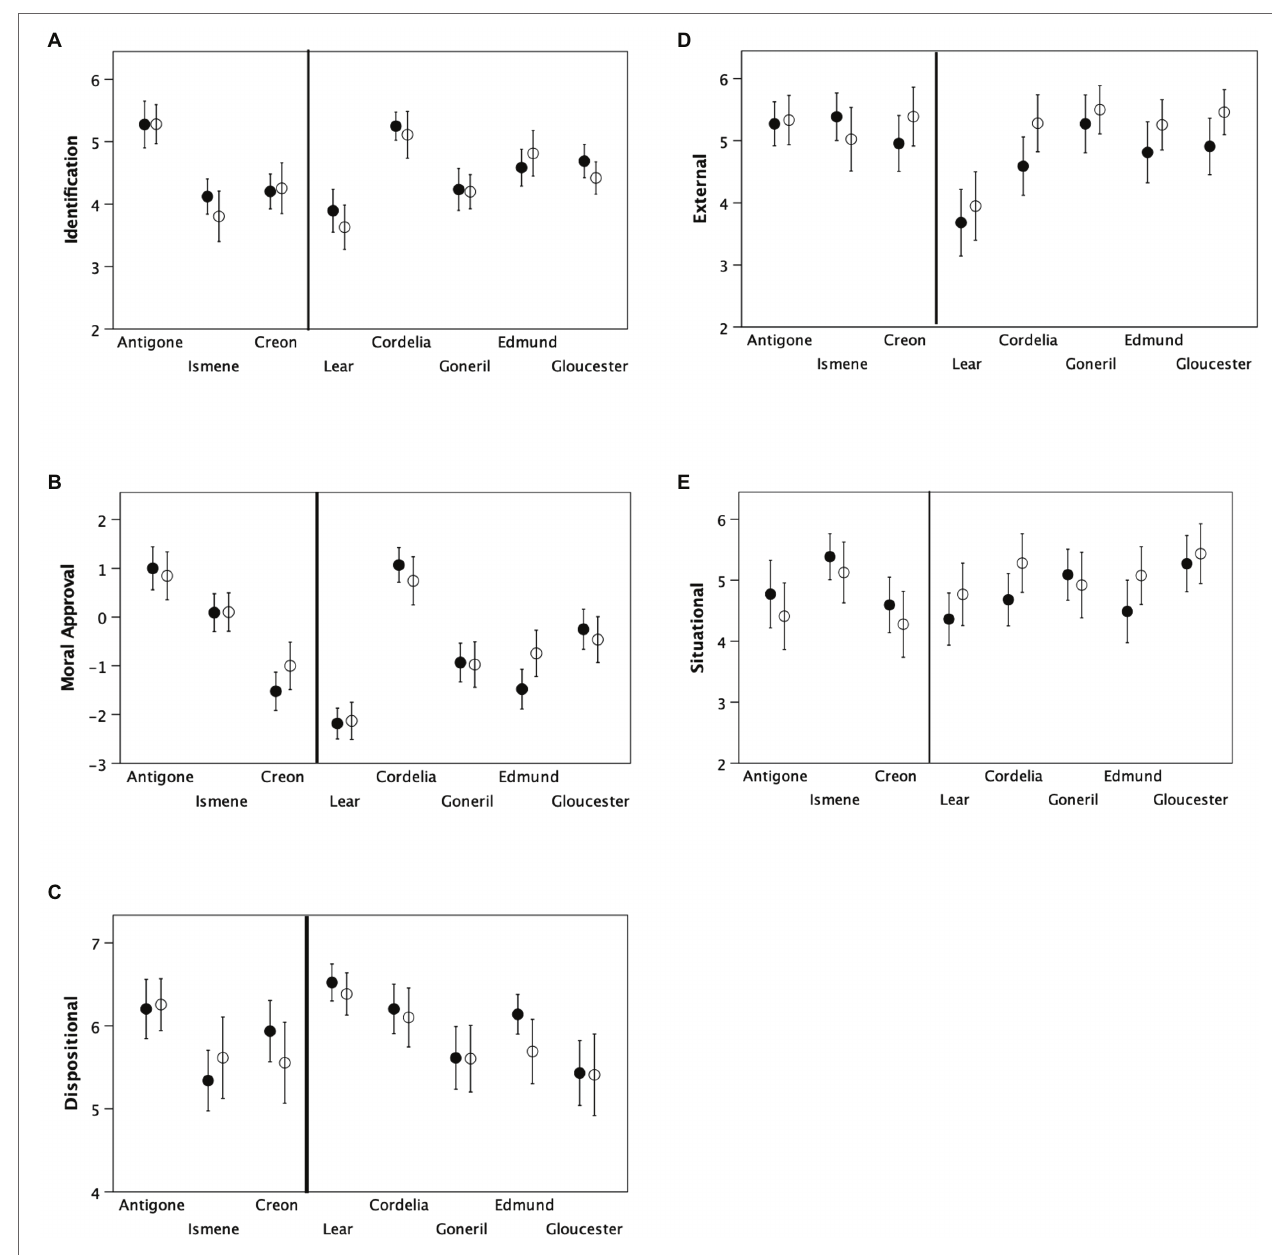
FIGURE 1 | Mean (±95% CI) for the five variables for each of the main characters in the two plays for (A) composite score on the Tal-Or and Cohen (2010) Identification scale, (B) Moral Approval ratings and (C-E) scores on the three dimensions of the Kinderman and Bentall (1996) Attribution scale. Filled symbols: conventional characterisation; unfilled symbols: reversed